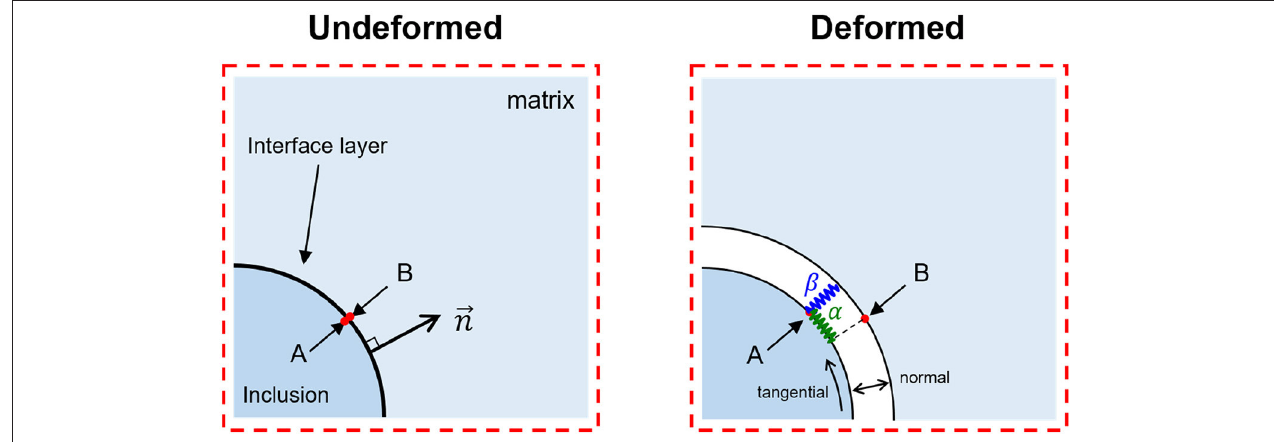
FIGURE 4 | Schematic of an interface spring model in elasticity. To visualize the interface spring in two directions, we compare undeformed and deformed